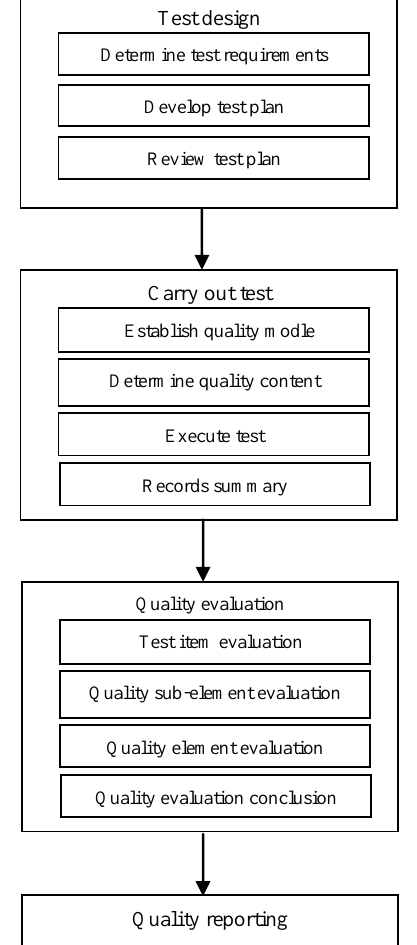
Figure 3. Quality testing and evaluation process of fundamental geographic information database